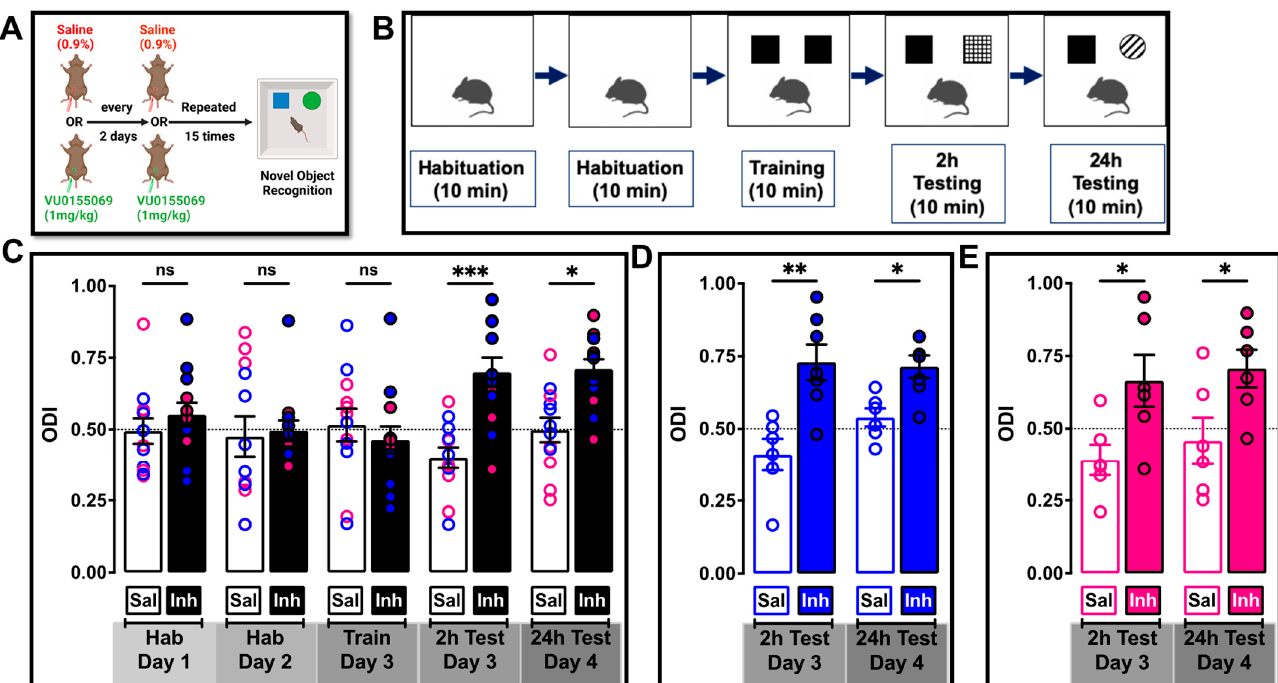
Figure 7. Chronic PLD1 inhibition rescues NOR deficits in 12-month-old 3xTg-AD mice. ( A ) Both male and female 3xTg-AD mice were injected (i.p.) with 1mg/kg VU01 or 0.9% saline every alternate day to receive a total of 15 injections for a period of 1 month. ( B ) The schematic depicts the regimen of the protocol described in the methods section. ( C ) The object discrimination index (ODI) measures the relative time spent by the animal in the novel object area compared to the total amount of time spent with both objects. There was no bias observed with any of the areas associated with either object in both groups of animals during habituation days (labeled in grey below X-axis, ns, not significant). On the training day, we did not observe any bias for the objects or the associated area for either group, suggesting that learning was not affected. There is a significant difference between the groups at the 2 h (*** p = 0.0003) and 24 h (* p = 0.0211) test where the inhibitor-treated group spent more time with the novel object compared to the saline-treated siblings. The saline-treated animals do not differentiate between the novel object and the familiar object relative to the PLD1 inhibitor-treated animals, providing evidence for compromised memory. Data were separated into ( D ) males (n = 6–7) 2 h (** p = 0.0014) and 24 h (* p = 0.0404) and ( E ) females (n = 6) 2 h (* p = 0.0275) and 24 h (* p = 0.0412) and PLD1 inhibition showed efficacy in both sexes. Saline-treated animals are shown in clear bars while inhibitor-treated animals are shown in filled bars. Each circle represents a single animal. Saline circles have colored borders while inhibitor circles have black outline filled with color. Pink color represents female, while blue represents male mice. Values are expressed as mean ± SEM, n = 12–13 mice, Holm–Sidak’s multiple comparison test and Kruskal–Wallis test.